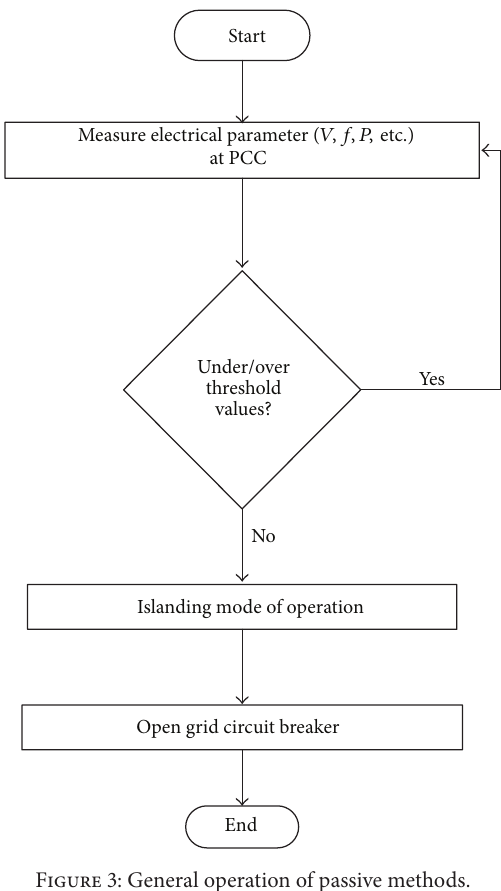
Figure 3: General operation of passive methods.